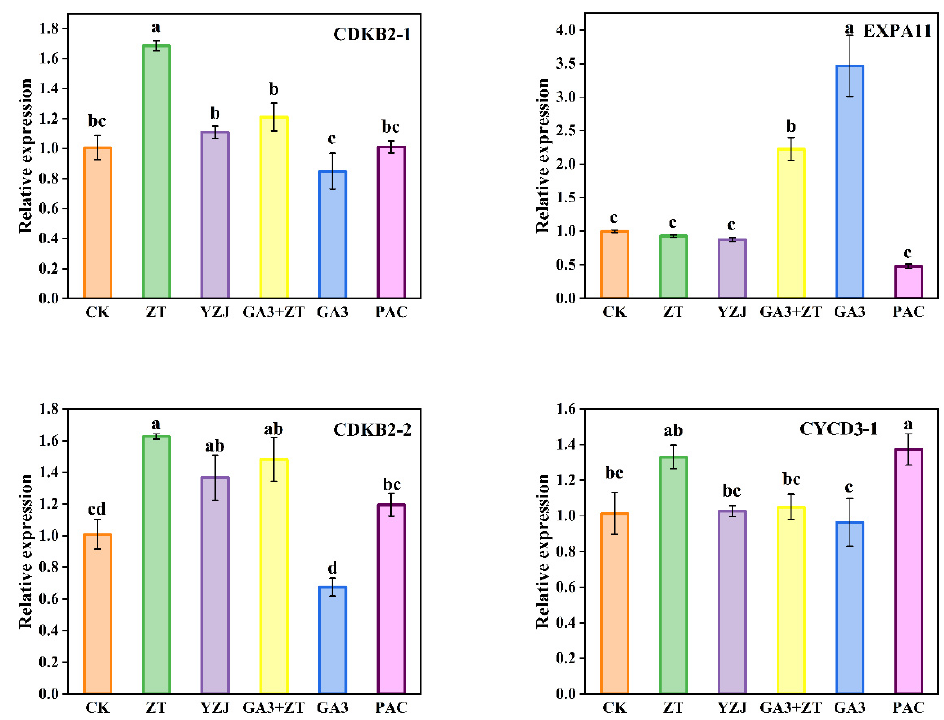
Figure 4. Expression profiles of flowering elongation and cyclin genes in flowering Chinese cabbage. Data represent the mean ± standard error for three biological experiments, with standard errors shown as bar charts above the columns, while lowercase letters indicate significance at p < 0.05.